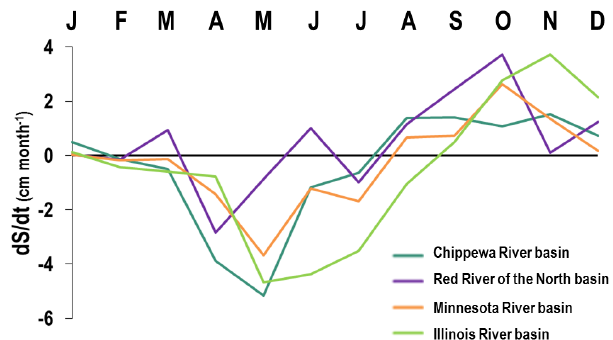
Figure 10. Average monthly (January–December) change in basin soil moisture, groundwater, and/or reservoir storage (d S/ d t ), calcu- lated after land cover transition (LCT) years (see Table 3 for the Illinois River basin, Minnesota River basin, and Red River of the North basin LCT years), and after 1975 for the Chippewa River basin assuming a 17% reduction in ET a for summer